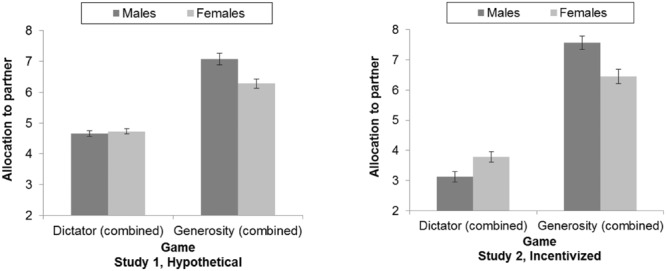
Mean allocations to partner by game type and gender. Data are collapsed across reciprocity conditions. Error bars represent one standard error. N = 301 (Study 1), 256 (Study 2).